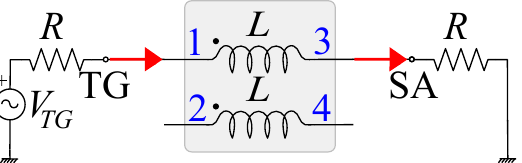
Figure 7. Open-circuit (OC) setup proposed in [16] for characterizing CMCs.